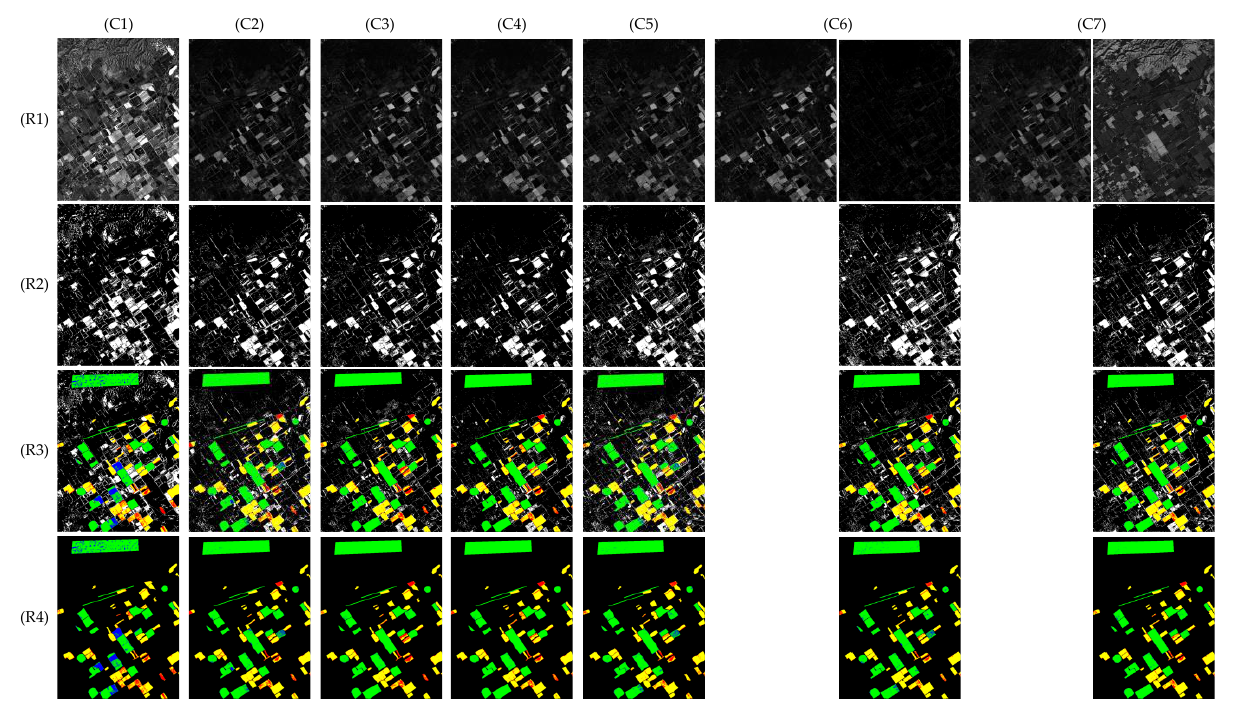
Figure 9. Visualization of comparison on dataset ‘Santa Barbara’. ( C1 ) CVA, ( C2 ) CD-FCN, ( C3 ) DSFA, ( C4 ) CD-USNet, ( C5 ) CD-CSNet, ( C6 ) CD-SDN-AM, ( C7 ) CD-SDN-AL; ( R1 ) CPM, ( R2 ) BCM, ( R3 ) F-HSM, ( R4 ) K-HSM.